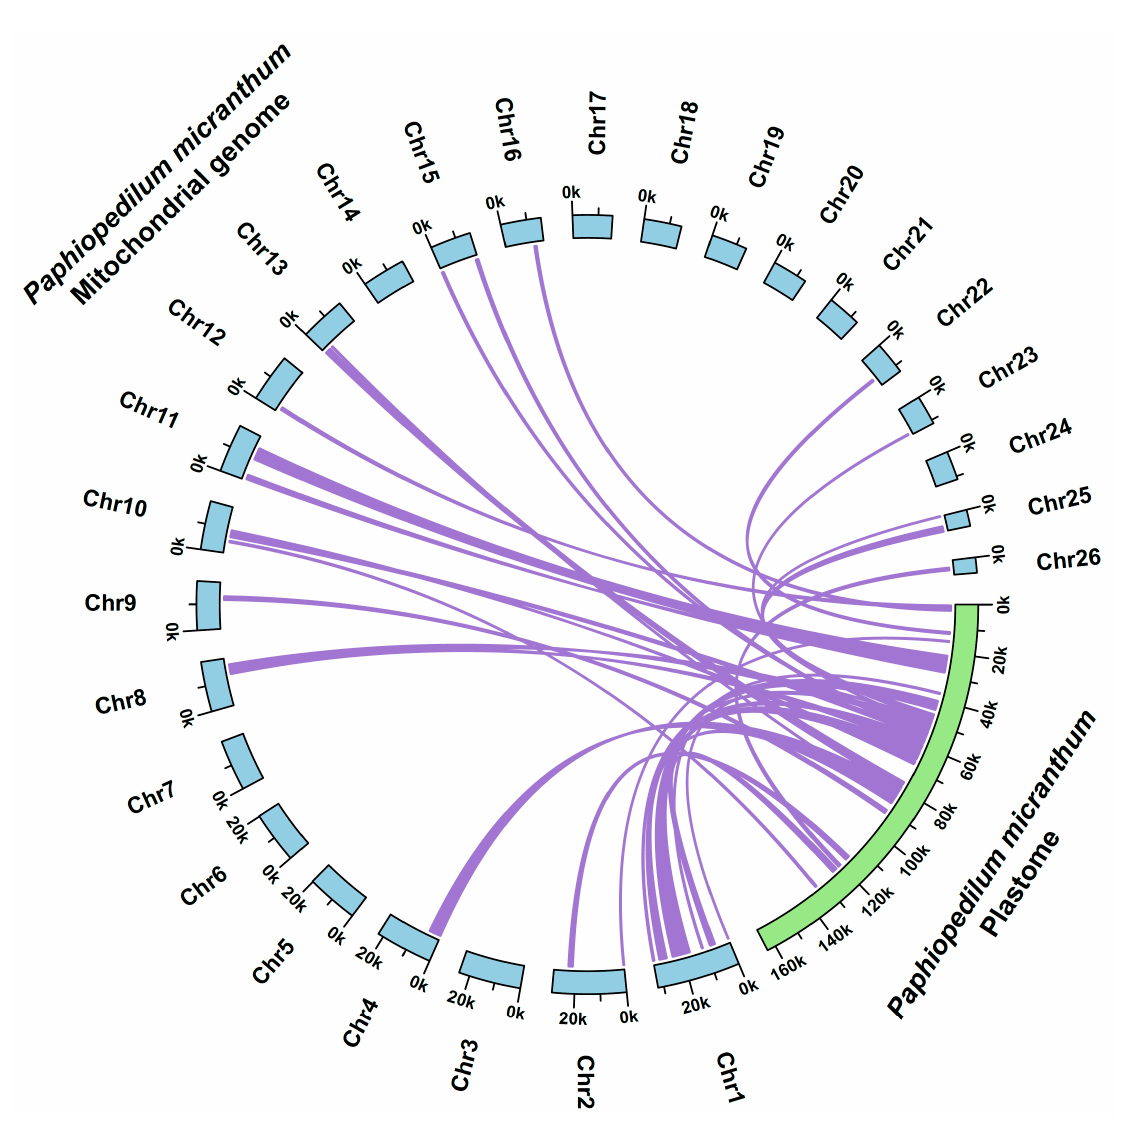
Figure 3. Schematic diagram of gene transfer between the plastome and mitogenome of Paphiopedilum micranthum.